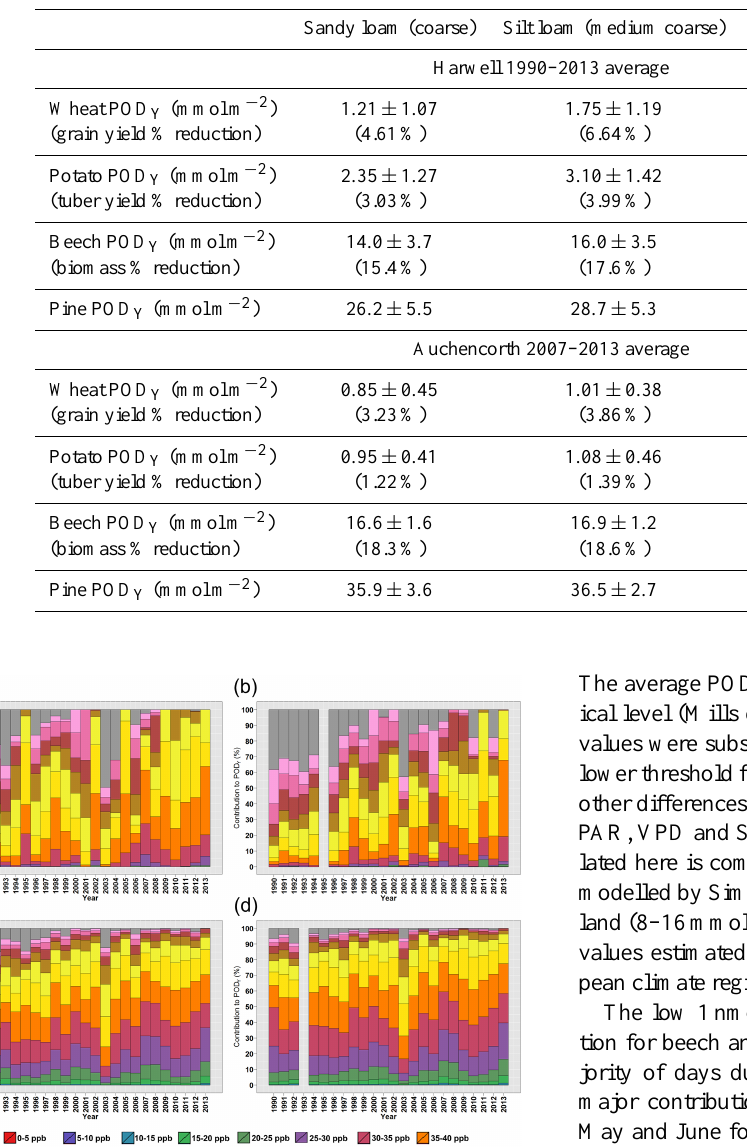
Table 1. Average ± SD wheat, potato, beech and Scots pin POD Y calculated for four different soil textures (see Bueker et al., 2012, for a description of their hydraulic properties) over the monitoring periods at Harwell and Auchencorth.